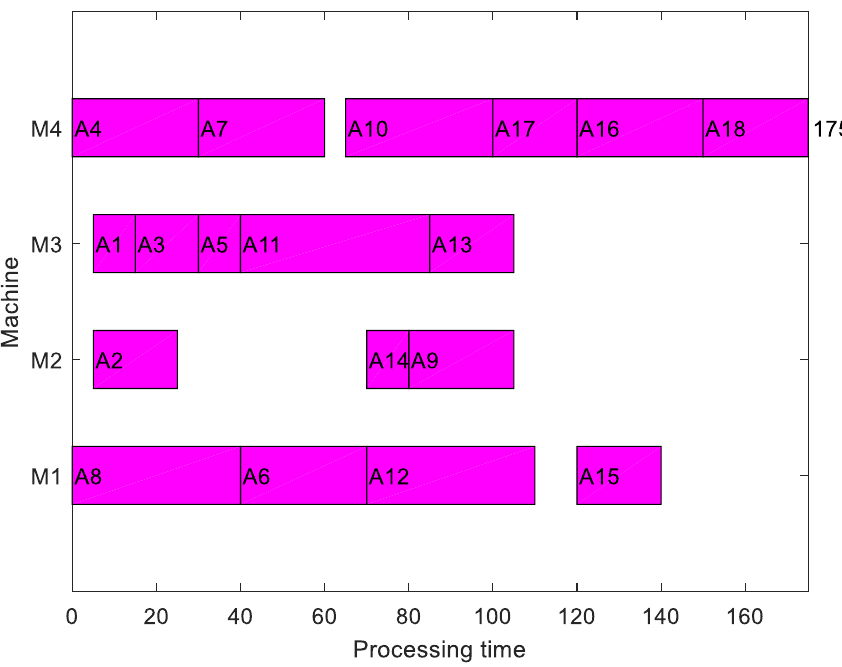
Figure 9. A forward-sequence scheduling Gantt chart with the transformation strategy applied to the schedule shown in Figure 4.